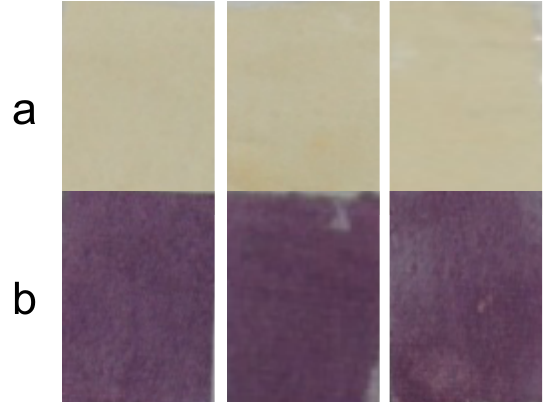
Figure 4. Appearance of the UVM7-cotton sample previously ( a ) and after ( b ) the exposition to HCl vapours. From left to right: zero, one, and three washing